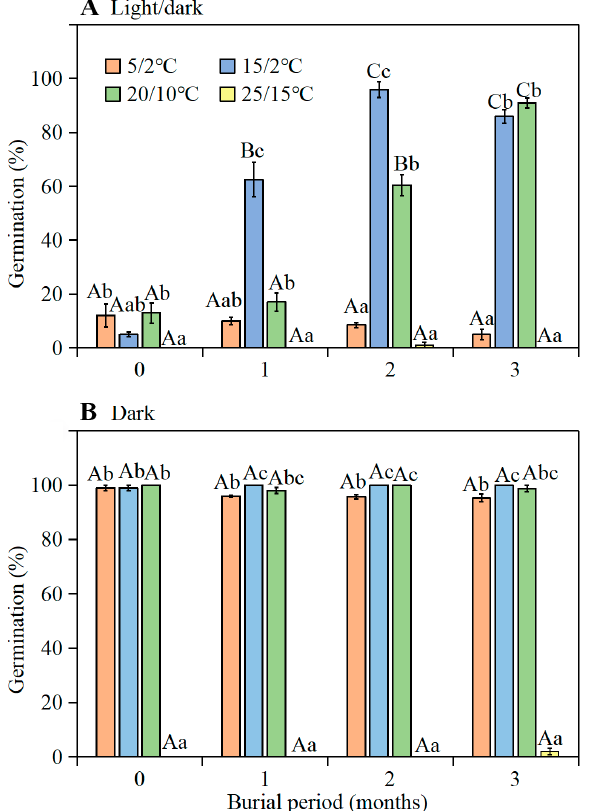
Figure 3. Final germination percentages (mean ± 1 s.e.) of a composite sample of seeds from flowers with long, intermediate, and short styles of Ixiolirion songaricum ( A ) in the light and ( B ) in the dark at four temperature regimes following 0-, 1-, 2-, and 3-months of burial in soil in experimental garden. Bars with different uppercase letters (A, B, C) indicate significant differences among different burial times at the same temperature regimes and different lowercase letters (a, b, c) significant differences among different temperature regimes at the same burial time in light or in dark (Tukey’s HSD, p = 0.05).